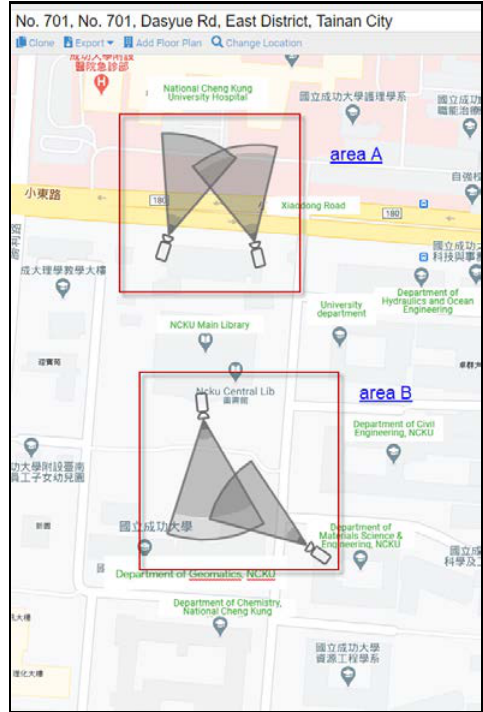
Figure 2. CCTV monitor field of view in 2D FOV Map (IPVM) Different from Figure 2, Figure 3 and Figure 4 show the FOV analyzed results after introducing the 3D perspectives using the viewshed analysis function of ArcGIS